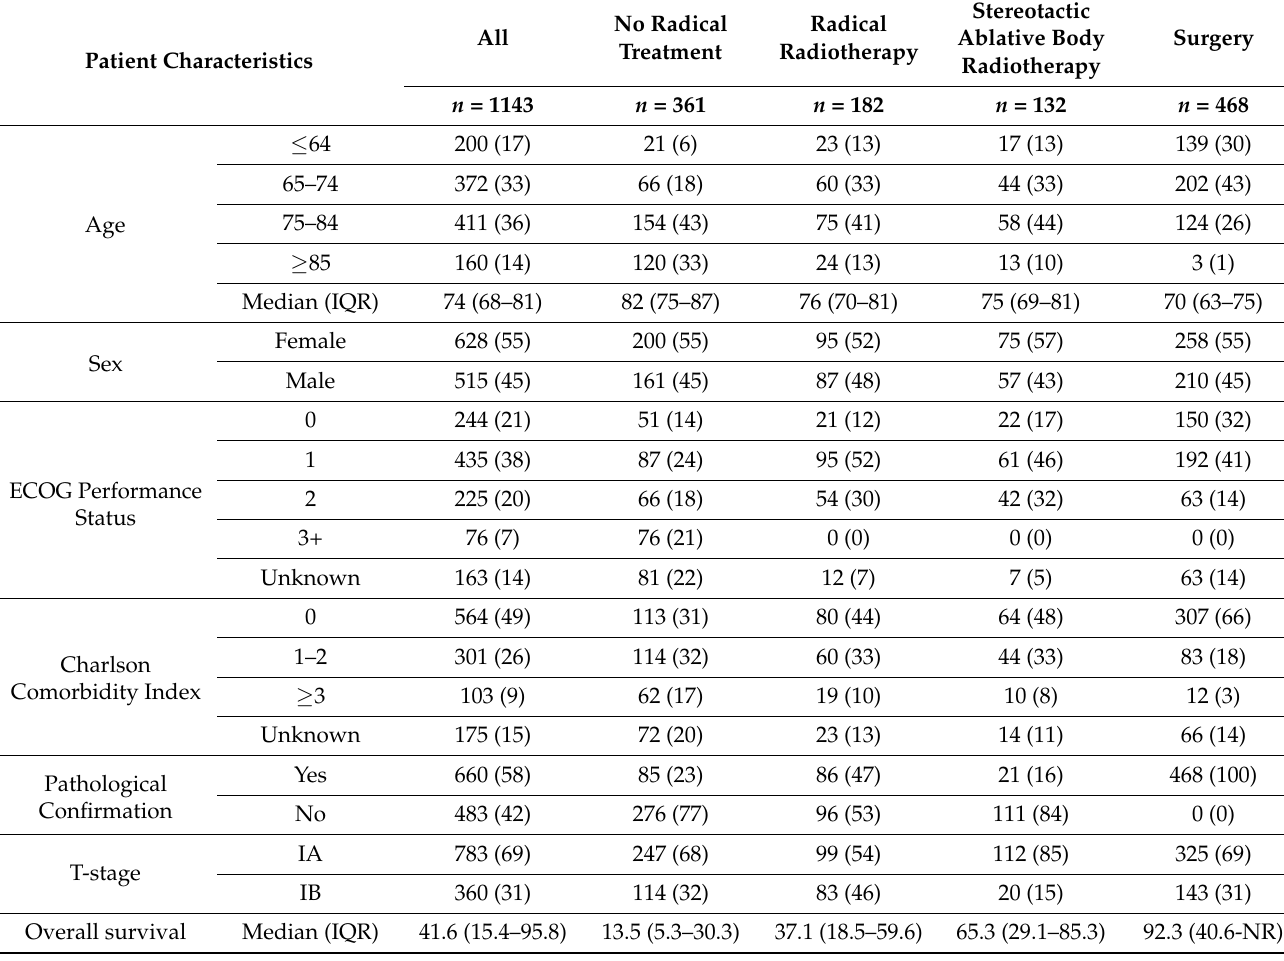
Table 1. Patient characteristics of patients with stage I NSCLC. (NR—not